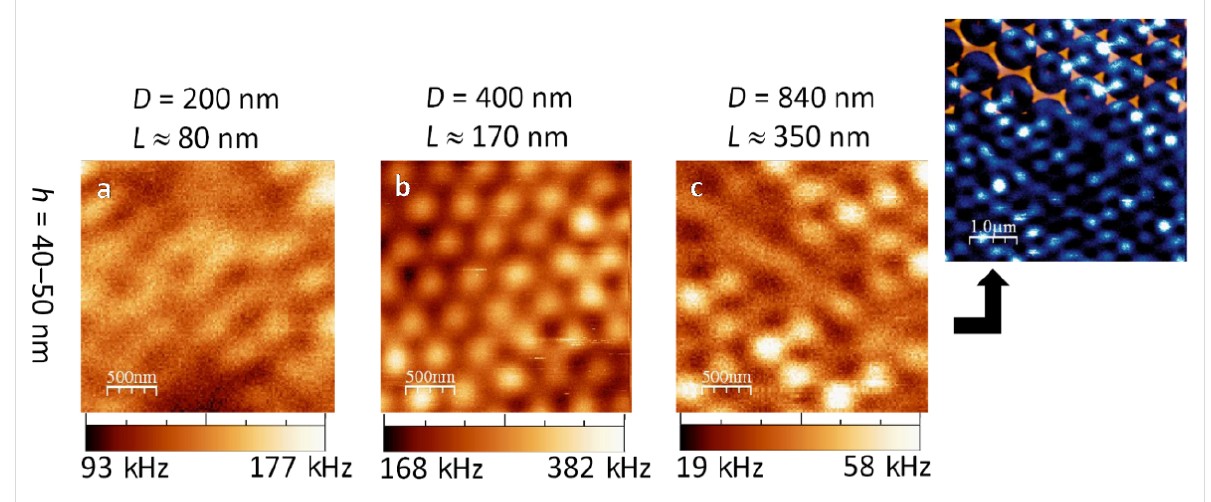
Figure 6: Confocal luminescence patterns of gold nano-triangles on glass excited by an azimuthally polarised laser beam . In (a) and (b) h = 40 nm, whereas in (c) h = 50 nm. The blue image was performed on the same sample as (c) and is an overlay of a topographical shear-force measurement (shown in blue) and a subsequent confocal optical measurement (shown in